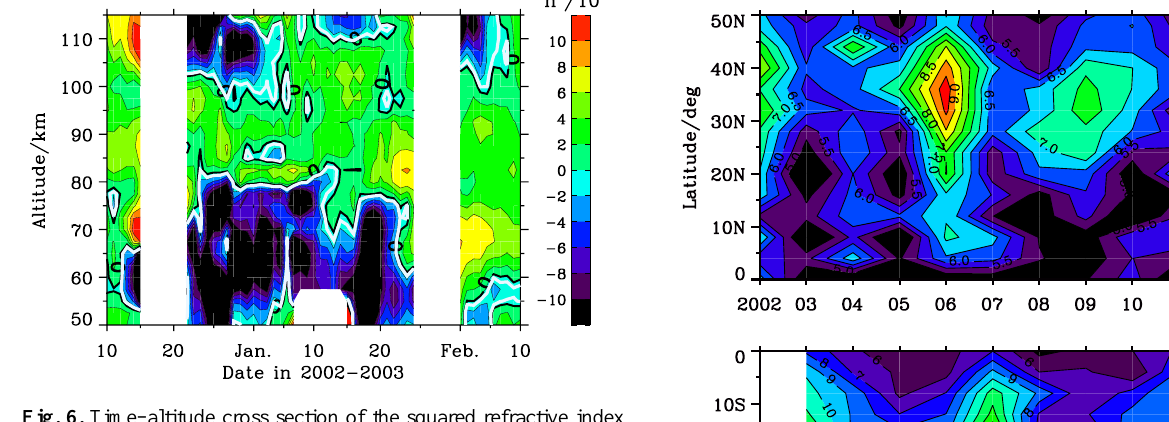
Fig. 6. Time–altitude cross section of the squared refractive index n 2 of (2.13, W3) at 32 ◦ S. White solid lines denote that q y equals zero. The blank areas (15–22 December, 7–14 January and 25– 31 January) denote unavailable data.